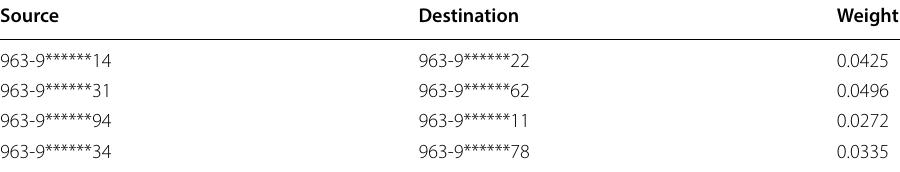
Table 4 Sample of Telecom social network data Source